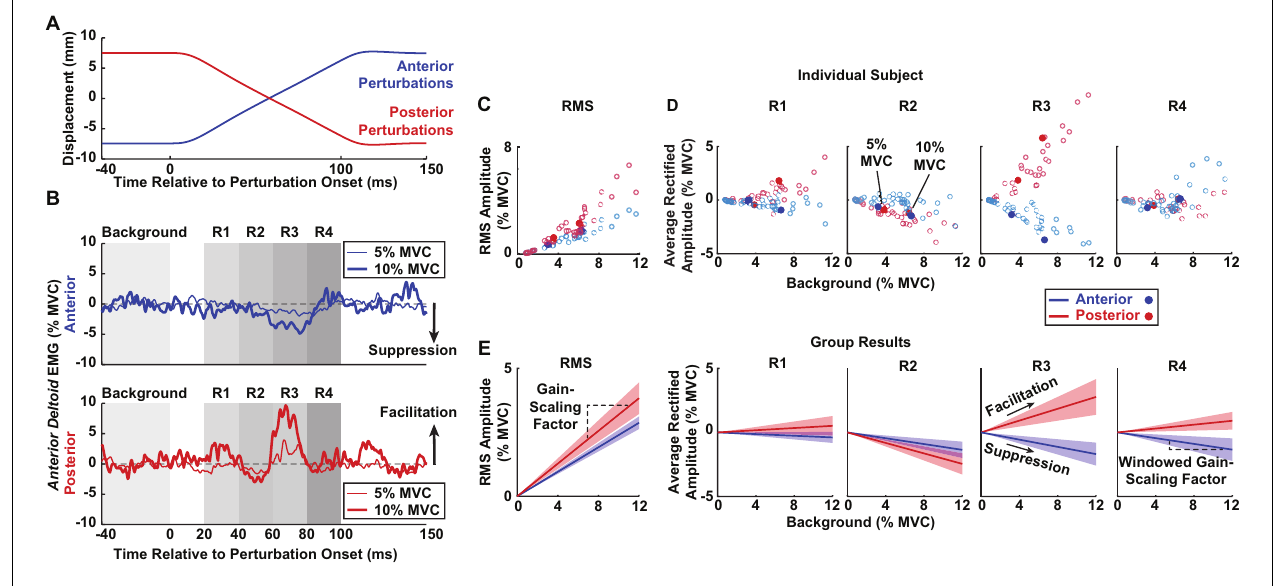
FIGURE 2 | Methods for estimating stretch-evoked reflexes. Sample data are displayed from a single participant to illustrate the methodology. (A) Anterior (blue) and posterior (red) perturbations were applied to the glenohumeral joint. Each perturbation had a peak-to-peak amplitude of 15 mm. (B) Average rectified EMGs of the anterior deltoid are displayed following anterior (top) and posterior (bottom) perturbations as participants generated torque at 5% (thin traces) and 10% (thick traces) MVC. Rectified EMGs were averaged across all perturbations in a trial and plotted relative to the average background EMG (0–40 ms prior to